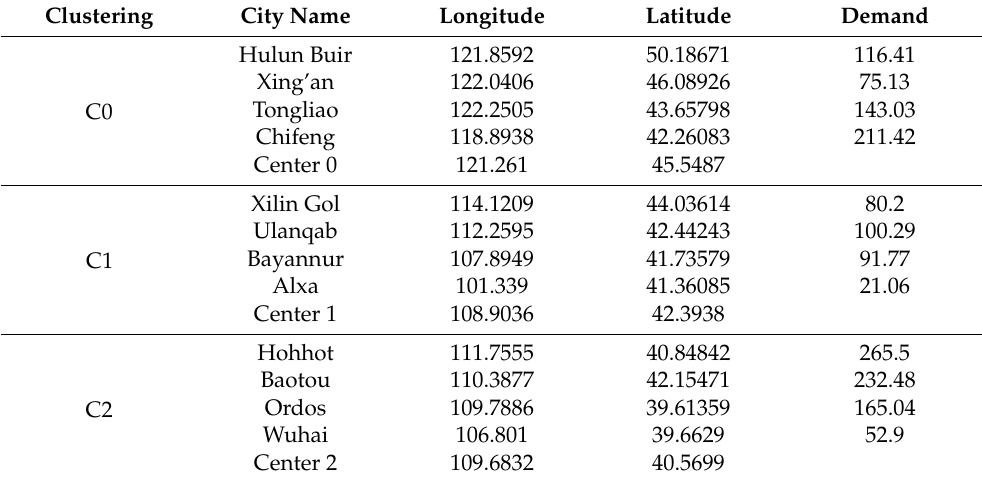
Model 3: Improved five-indicator clustering model (I5ICM). Based on the result of Model 2, this model incorporates the center-of-gravity method to obtain lower transporta- tion costs. The results are shown in Table 9 and Figure 7. C0, C1, C2 and Center are in different colors in Figure